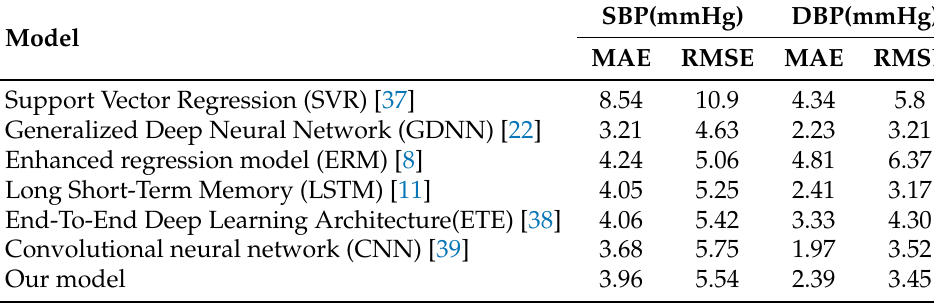
Table 1. Performance comparison between different BP estimation models.